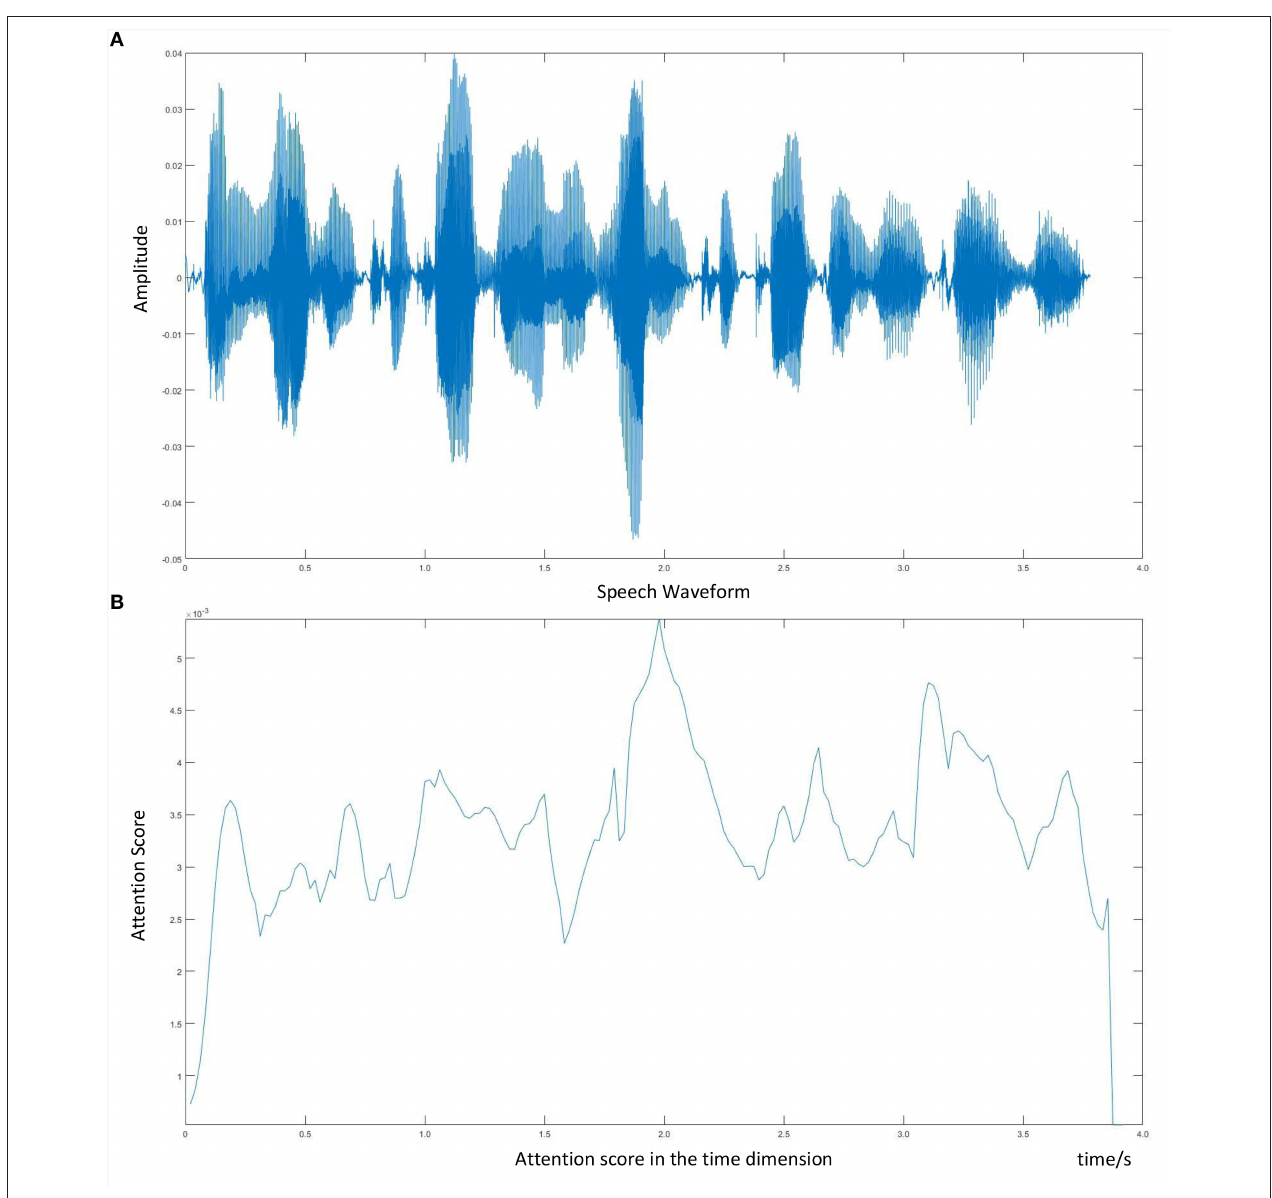
FIGURE 7 | Visualization of speech waveform and corresponding attention score. (A) Speech waveform. (B) Attention score in the time